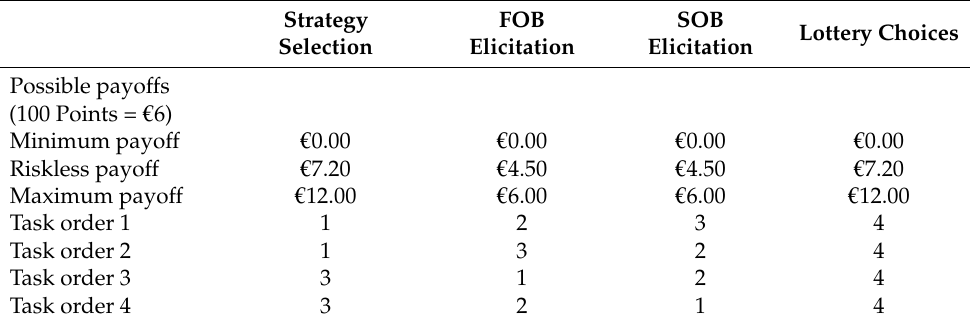
Table 2. Range of possible payoffs and task order within the experimental conditions.